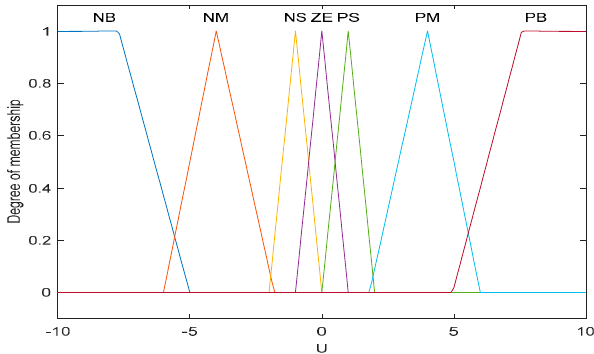
Figure 5. Membership function of fuzzy output variable (u).